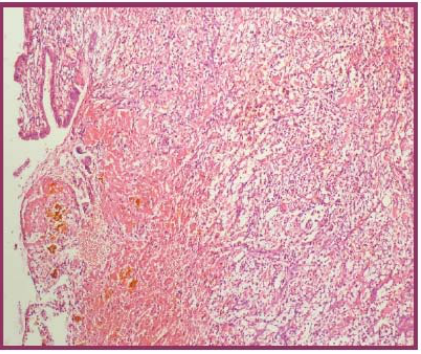
Fig. 3 Histopathology revealed erosion of the gallbladder mucosa with hemorrhagic